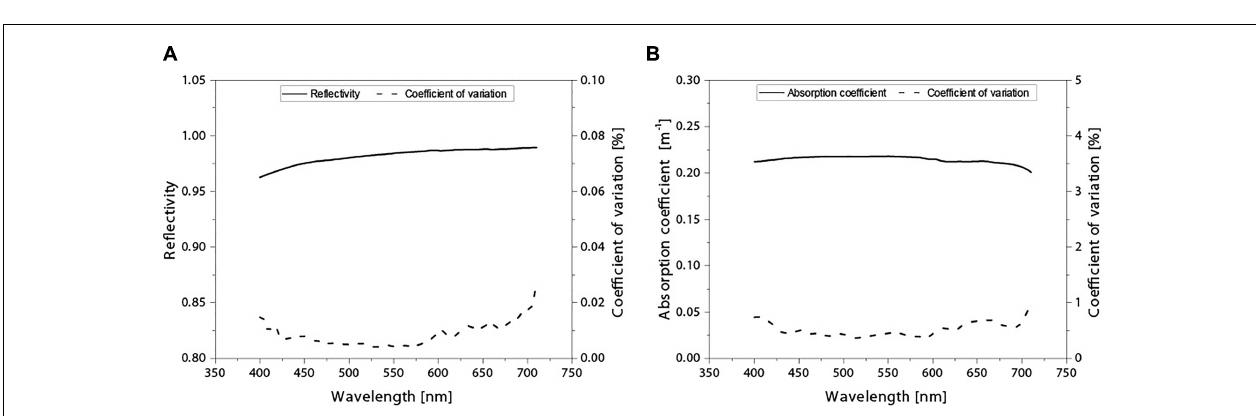
FIGURE 4 | Mean spectrum of the nigrosine solution used as standard ( n = 18). The dotted line gives the coefficient of variation based on the standard deviation of the replicate measurements.